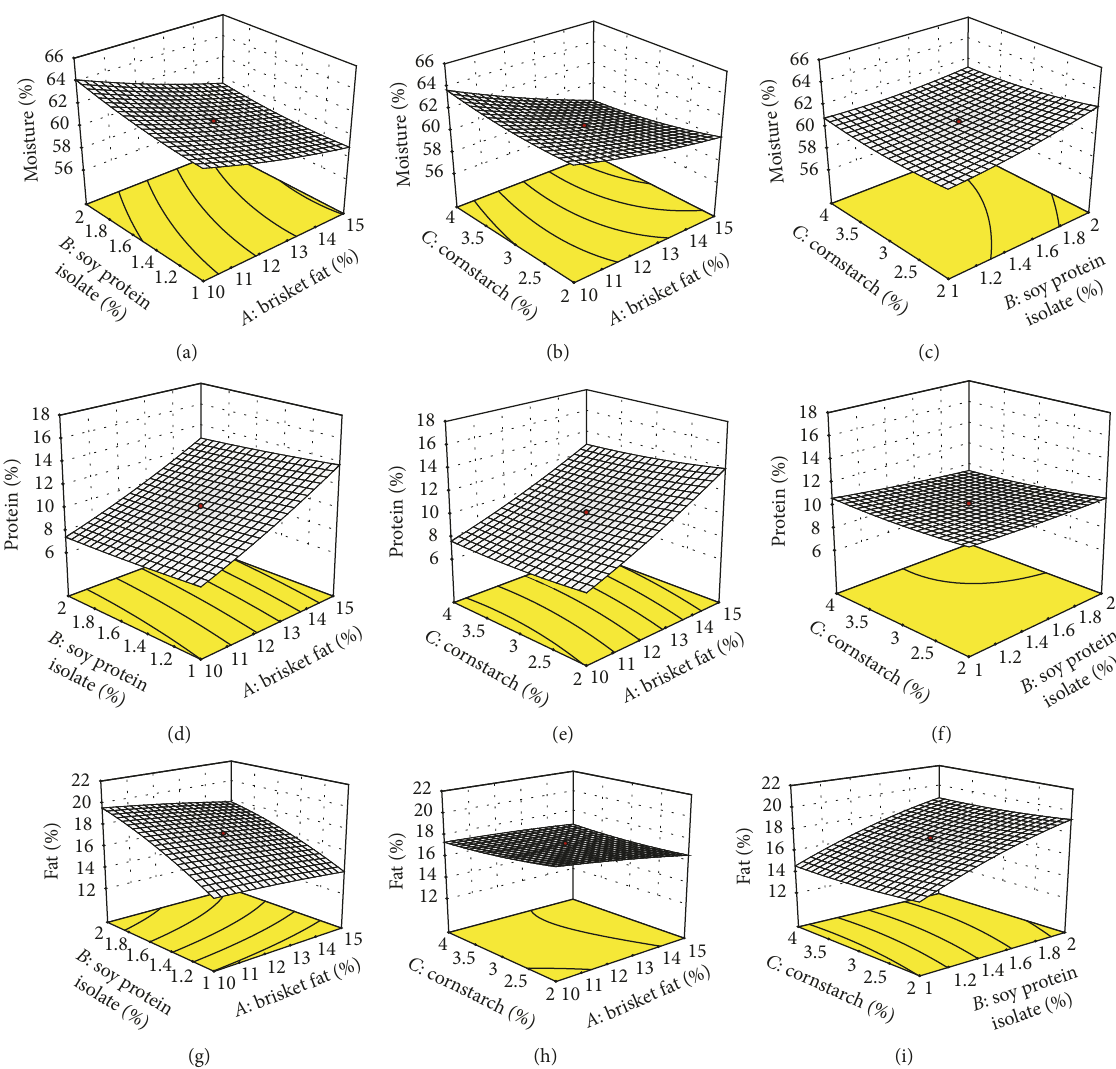
Figure 1: Effect of (a) brisket fat and soy protein isolate, (b) brisket fat and cornstarch, and (c) soy protein isolate and cornstarch on moisture content, (d) brisket fat and soy protein isolate, (e) brisket fat and cornstarch, and (f) soy protein isolate and cornstarch on protein content, and (g) brisket fat and soy protein isolate, (h) brisket fat and cornstarch, and (i) soy protein isolate and cornstarch on fat content along with the second-order polynomial model equations predicting effects of the variables. ((a), (b), (c)) Moisture = 60.77 − 2.01𝐴 + 0.59𝐵 − 0.28𝐶 − 0.29𝐴𝐵 − 0.66𝐴𝐶 − 0.39𝐵𝐶 + 0.24𝐴 2 + 0.28𝐵 2 + 0.32𝐶 2 . ((d), (e), (f)) Protein = 10.14 + 2.8𝐴 − 0.38𝐵 − 0.39𝐶 − 0.11𝐴𝐵 − 0.2𝐴𝐶 − 0.25𝐵𝐶 + 0.29𝐴 2 + 0.093𝐵 2 + 0.21𝐶 2 . ((g), (h), (i)) Fat = 17.15 + 0.63 𝐴 + 2.11 𝐵 − 0.23 𝐶 − 0.20 𝐴𝐵 + 0.28 𝐴𝐶 − 0.024 𝐵𝐶 − 0.096 𝐴 2 − 0.41 𝐵 2 + 0.19 𝐶 2